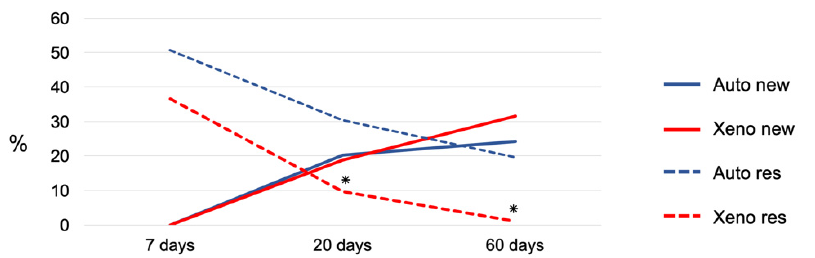
7 of 14 Figure 4. Cross-sectional microtomographic images of the autogenous (control) and xenogenous (test) groups showing the volumetric changes of the grafts after 7, 20 and 60 days of healing. Figure 5. Micro-CT images representing the healing after 60 days in the autogenous (control) and